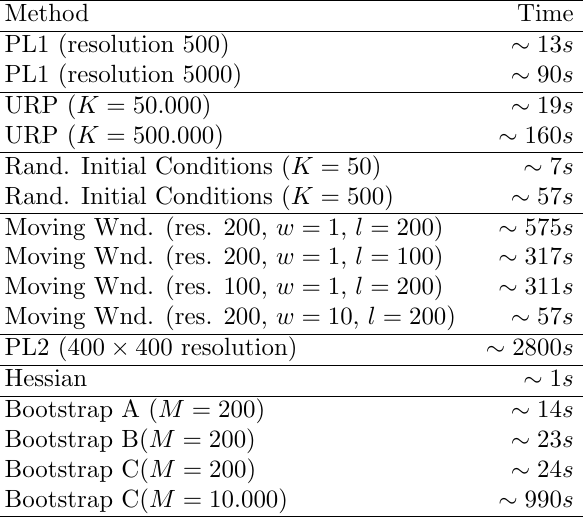
Table 3: Computation time for the LP model from the Step data-set. The other data-sets produce comparable execution